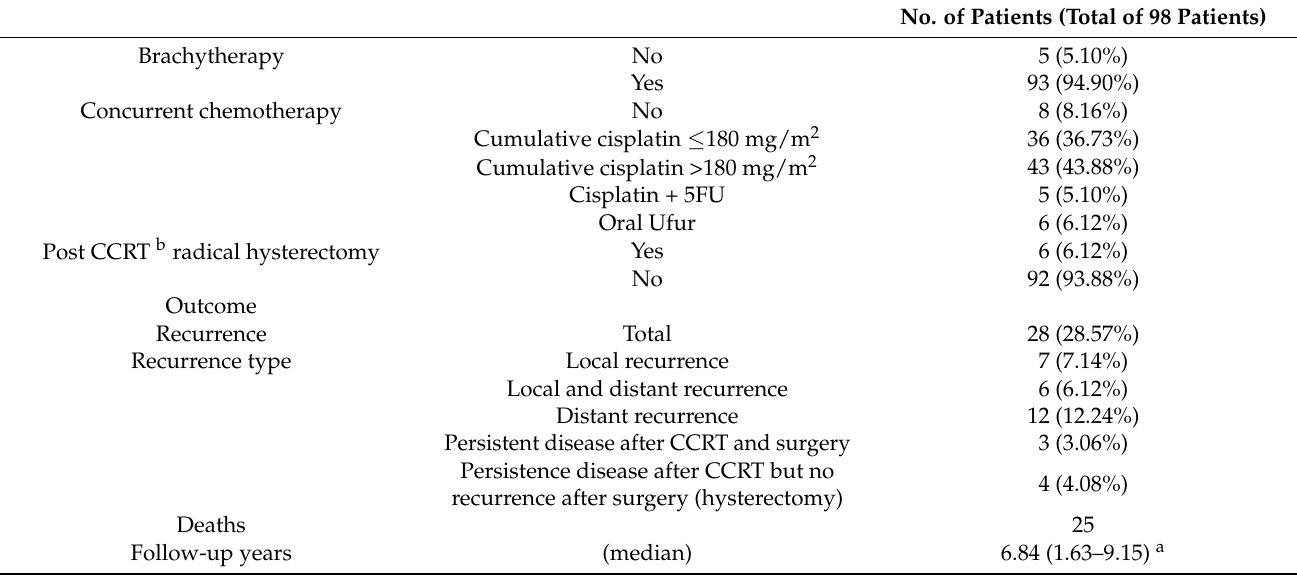
Table 2. Disease status and